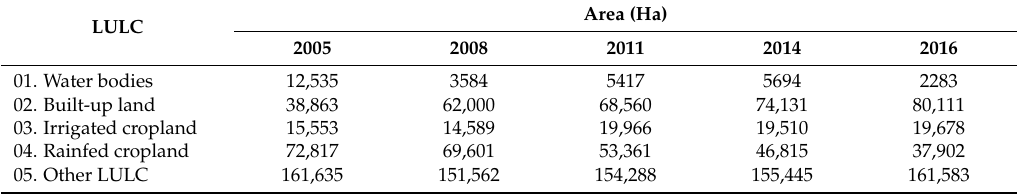
Table 2. Selected land-use/land-cover (LULC) data for the years 2005, 2008, 2011, 2014 and